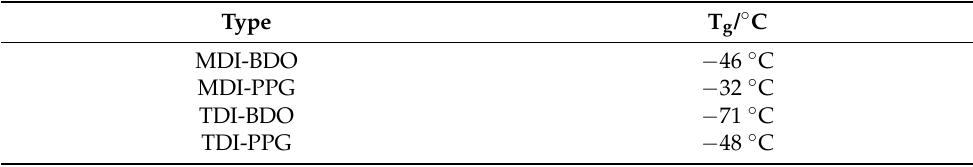
Table 9. T g of common polyurethane